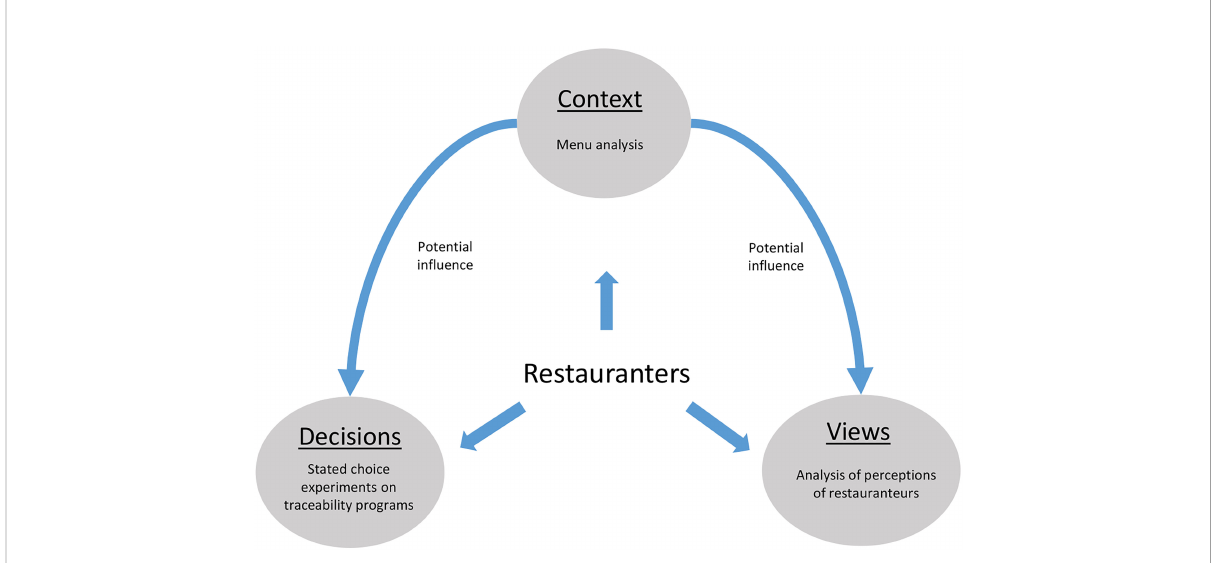
FIGURE 1 Exploring the context, decisions, and views of Chilean restauranters on seafood sustainability. Using a mixed methods approach, we use a menu analysis, stated-choice experiment, and perception survey to provide insights on different factors that in fl uence restaurateurs ’ ability to promote sustainable seafood. We also explore how local context (e.g., what seafood is being served) might in fl uence restauranters ’ decision-making and views about